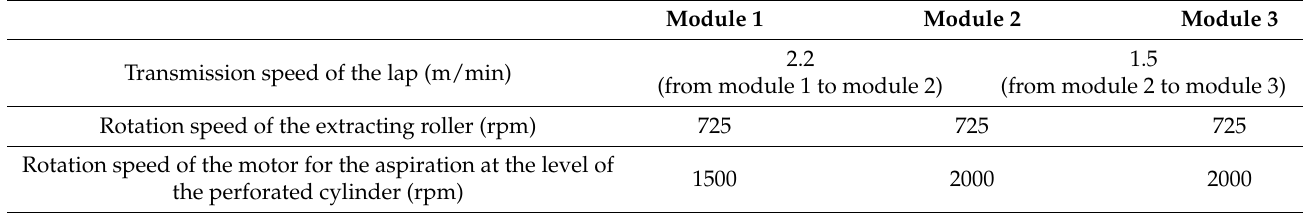
Table 2. Operating parameters used for the “all fibre” extraction device (same parameters used as those developed in Khan et al. [16]).